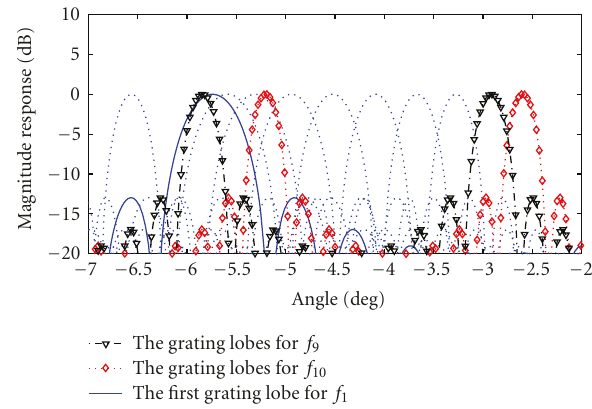
Figure 11: The di ff erent locations of grating lobes before combin- ing, Δ f = 201MHz, L = 20 λ 0 / 2.